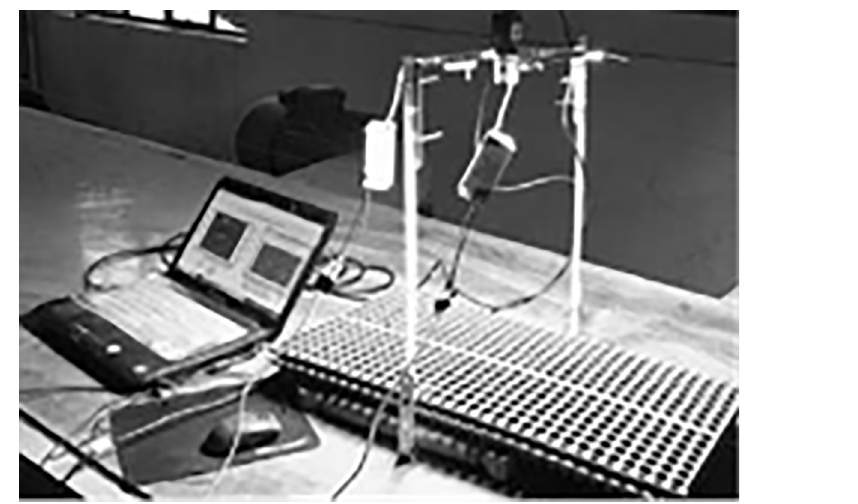
Fig 4. Hardware system of corn precision seeding.